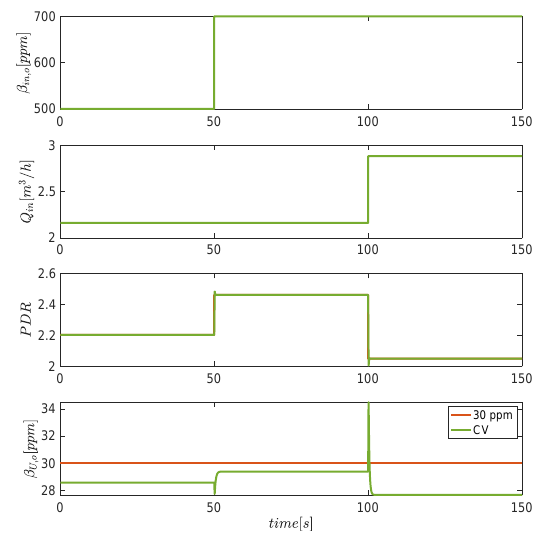
Figure 7: Simulation results showing the feed-forward control scheme. Here, the inlet oil concen- tration changes at 50 s and the inflow rate is changed at 100